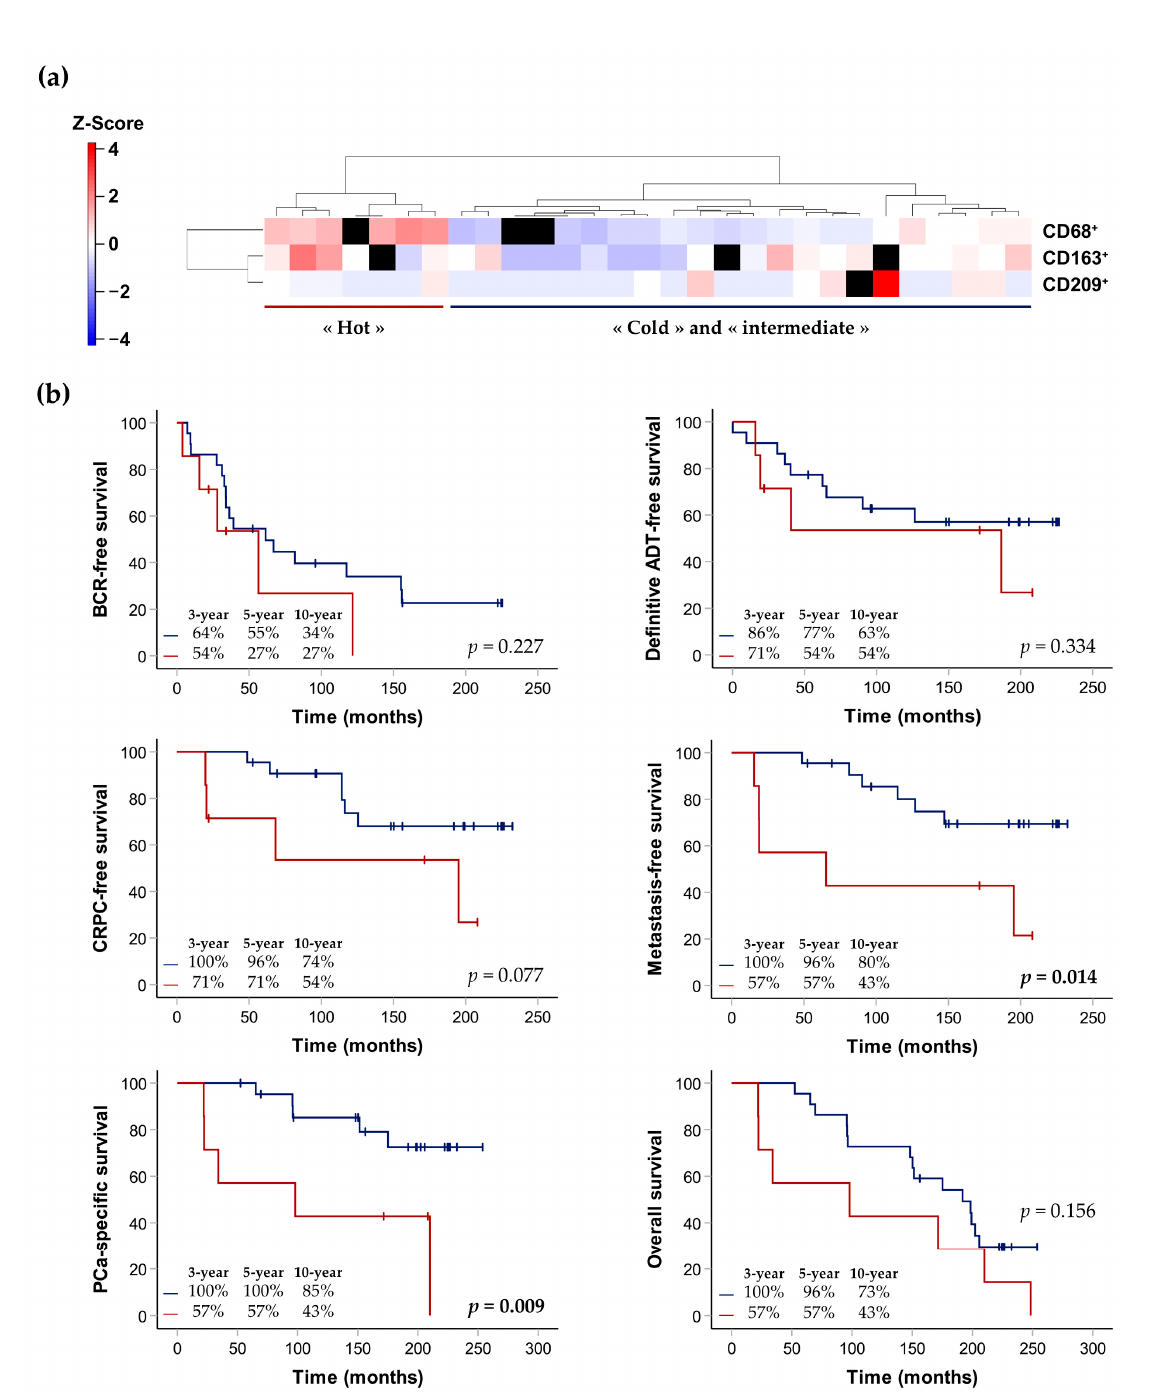
Figure 8. Hierarchical clustering of the three selected immune-cell markers according to cell densities in hotspots ( a ) and Kaplan–Meier curves exploring survival rates of patients with immunologically “cold/intermediate” IDC-P (blue) and patients with immunologically “hot” IDC-P (red), depending on the density in hotspots ( b ). ( a ) On the left side: cell-density scale from dark blue (low) to dark red (high). Each row corresponds to a patient and missing slides/quantification data are represented by black squares. One IDC-P-positive patient with two missing quantification data was excluded, bringing the total number of patients to 29. ( b ) The p -values were calculated using the log-rank test. Three-, five- and ten-year survival rates are indicated in the bottom left of each graph. ADT: androgen-deprivation therapy; BCR: biochemical recurrence; CRPC: castration-resistant prostate cancer; IDC-P: intraductal carcinoma of the prostate; PCa: prostate cancer.